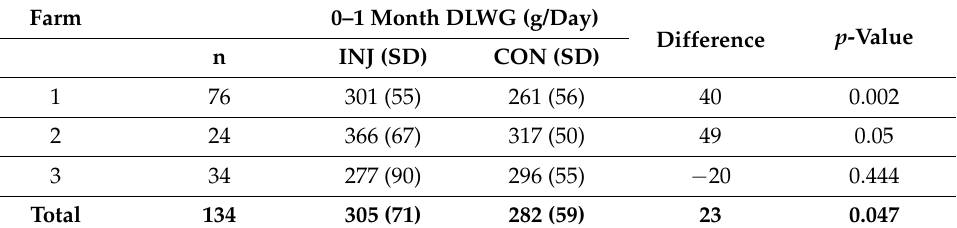
Figure 1. Mean overall DLWG on the farms with error bars (kg/day). Table 5. Overall DLWG in lambs, 0–1 month, singles only.